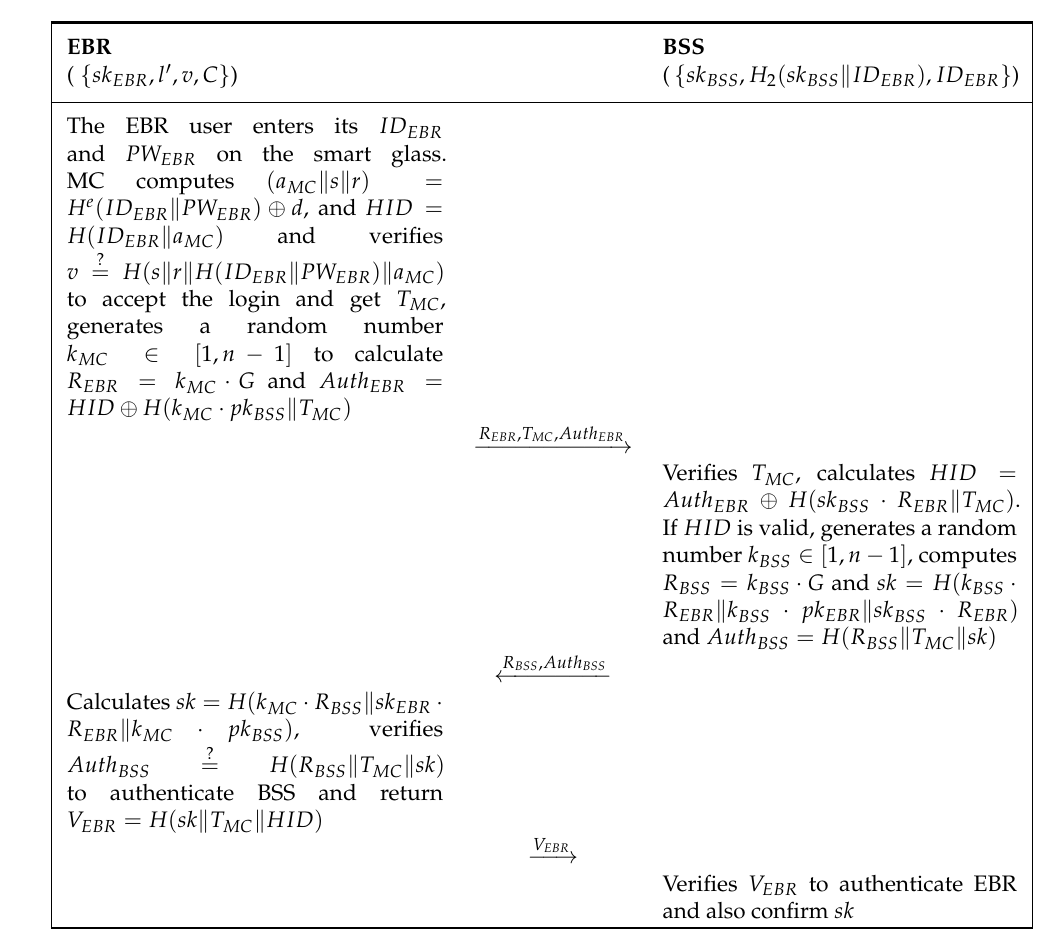
Figure 4. Mutual authentication phase of LLAKEP + scheme to share a session key between EBR and BSS